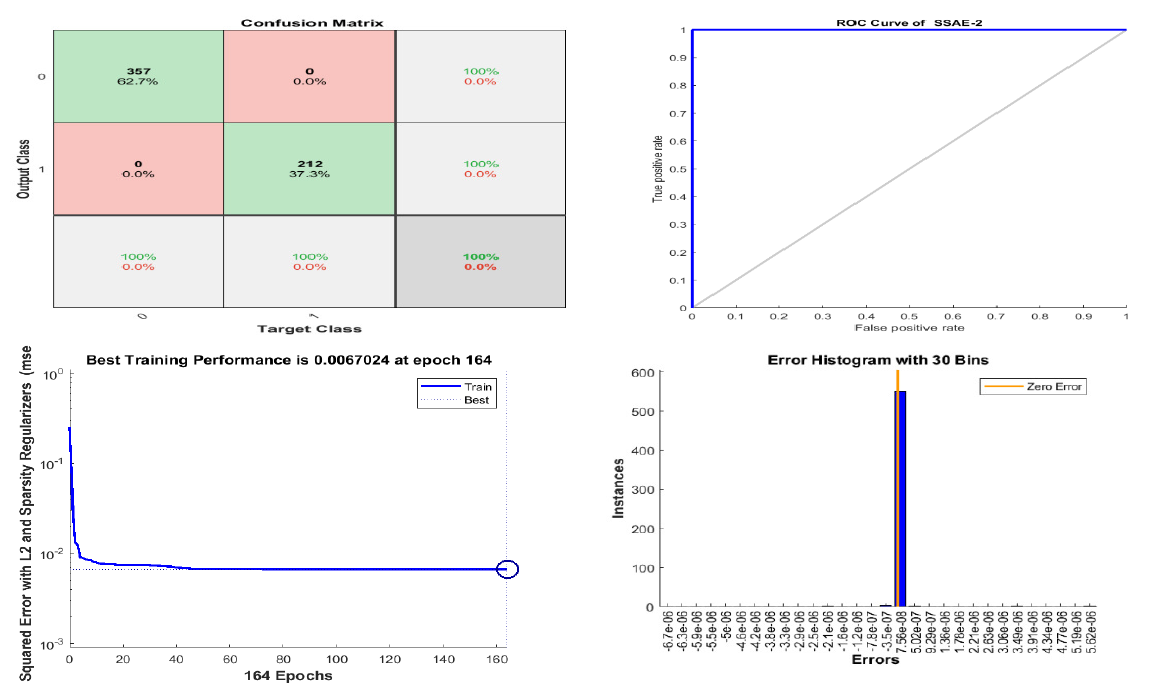
Fig. 3: Performance Measurements of SSAE with WDBC dataset